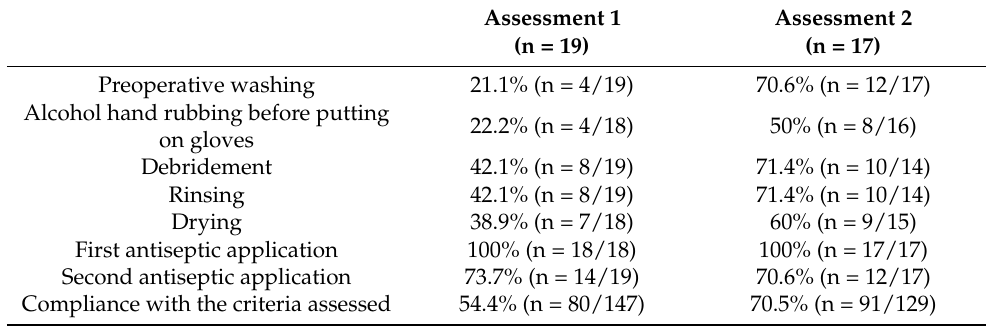
Table 3. Compliance with the criteria assessed on the skin preparation during orthopedic